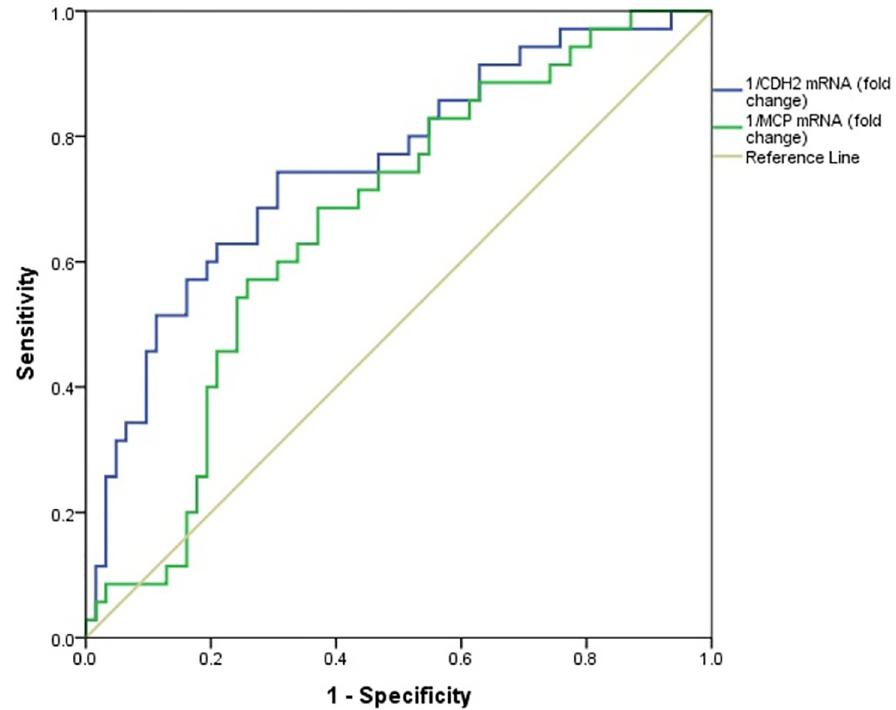
Fig 5. The receiver operating characteristic (ROC) analyses of 1/CDH2 mRNA and 1/MCP-1 mRNA to differentiate overt DN patients from DM patients.